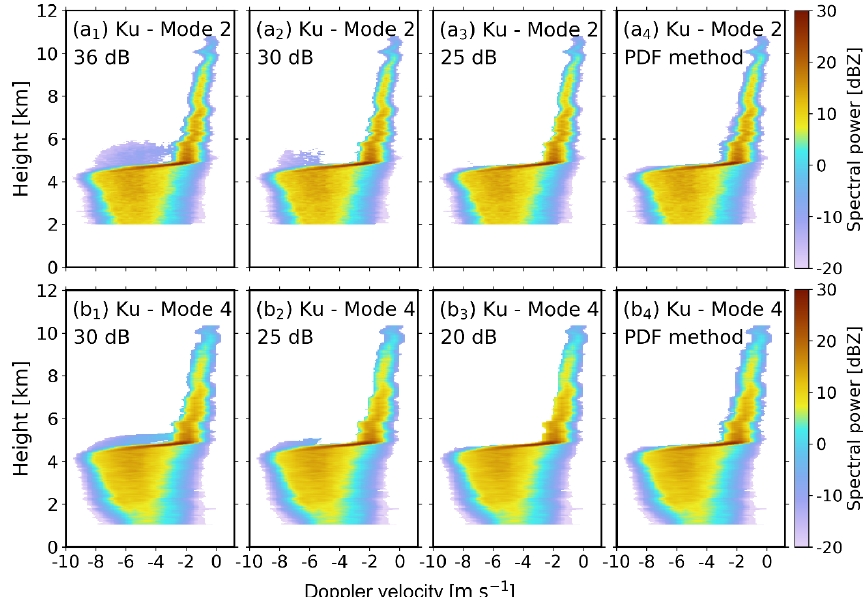
Figure C1. Ku-band Doppler power spectra after mitigating range sidelobe at modes 2 and 4 after the sidelobe mitigation using the threshold method (a1–a3, b1–b3) and PDF method (a4, b4) on 6 June 2020 at 22:52:08LST. The Doppler spectra observations before the sidelobe mitigation can be found in Fig. 4b 1 and d 1